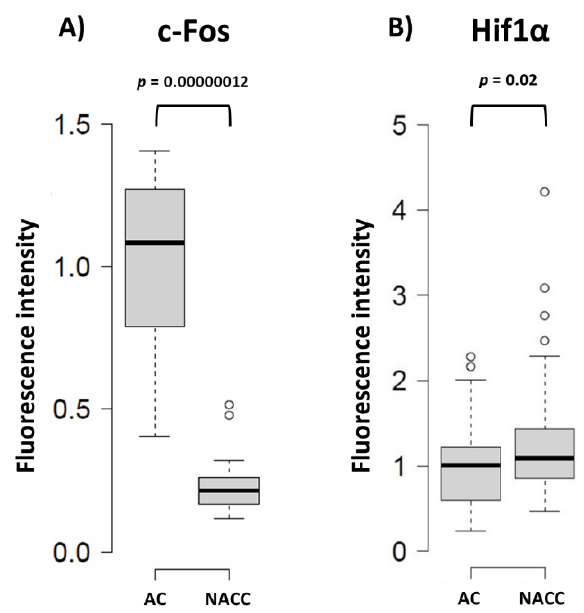
Figure 4. Quantification of the changes in the c-Fos and Hif1α protein-related signal in astrocytes under different conditions. ( A ) Neuron–astrocyte co-culture (NACC) reduces c-Fos-related fluorescence in astrocytes compared to astrocytic monoculture (AC); ( B ) Neuron–astrocyte co-culture increases Hif1α-related fluorescence in astrocytes compared to AC. Fluorescence intensity was normalized to control group.